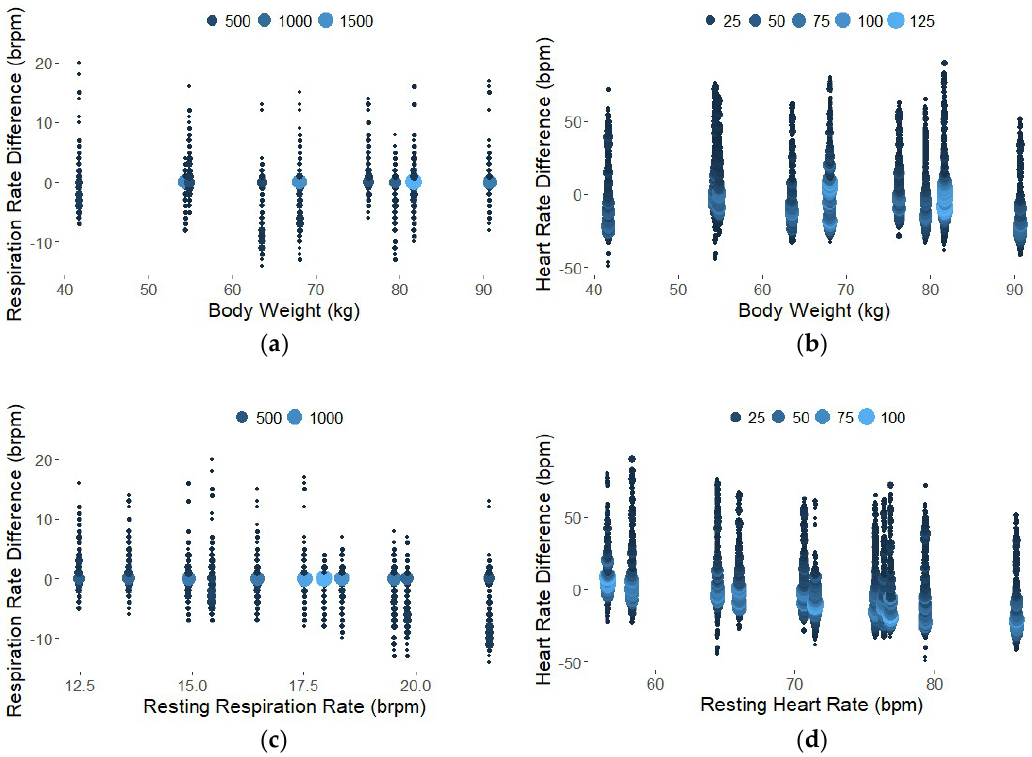
Figure 7. Bland-Altman plots to show reliability over weight ( a ) and ( b ) and over resting rates derived from the mean values over 30 min ( c ) and ( d ). Each data point represents the difference between the RR or HR calculated from the seat sensor compared to the Neulog for every time point and every participant. The size and color represent the density of overlapping points. Table 3. Summary Statistics for the Peak Detection and Frequency Analysis Techniques for RR and HR using all Time Points across all